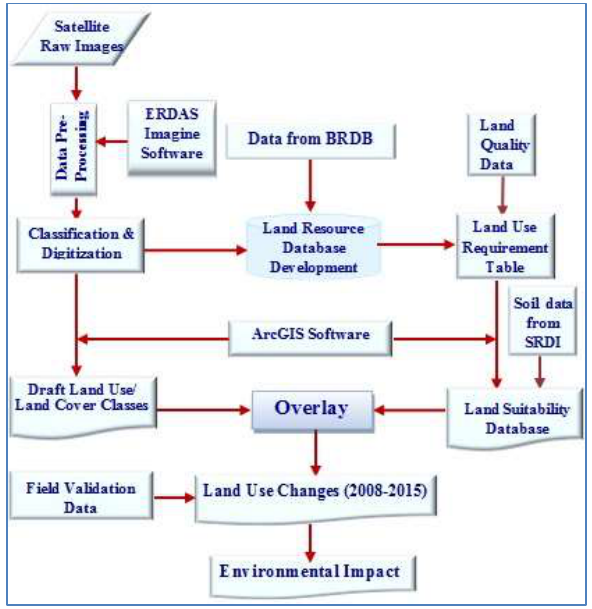
Figure 4. Steps of data generations